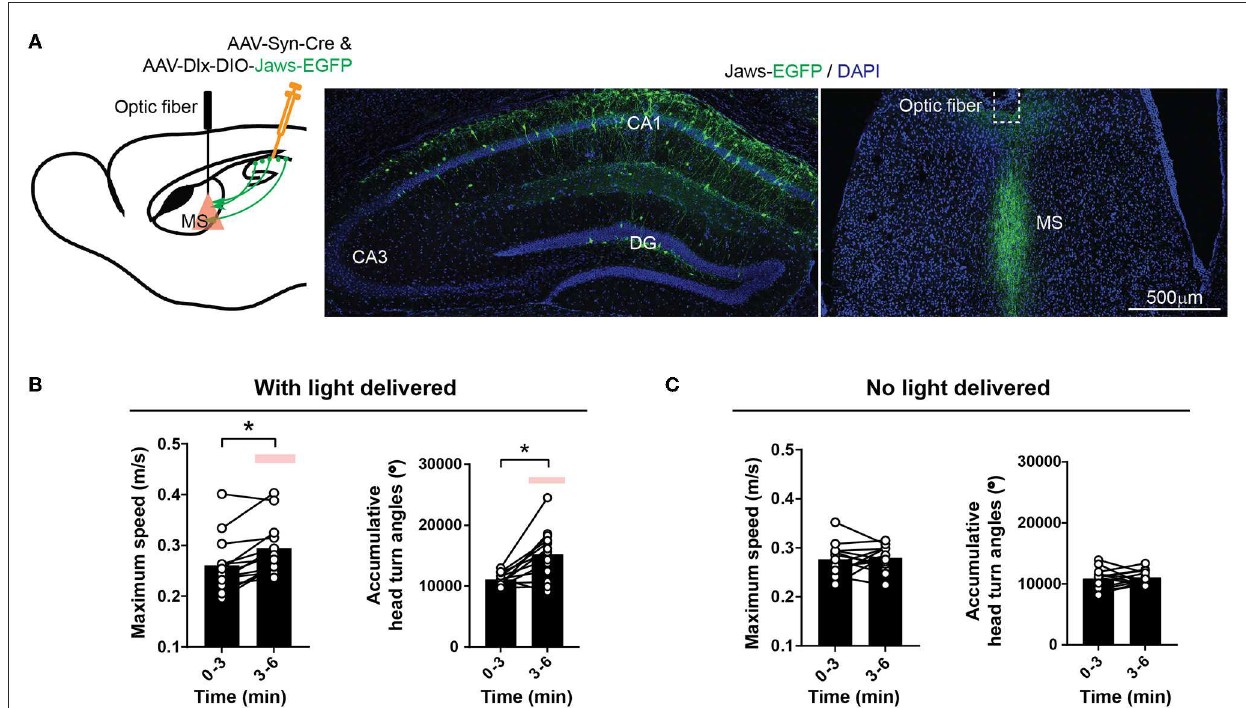
FIGURE5 Inhibiting inhibitory hippocampal output to the MS increases locomotion. (A) Optogenetic inhibition of the hippocampal inhibitory inputs to the MS by light delivered into the MS. An inhibitory opsin, Jaws, was expressed in the hippocampal GABAergic neurons with AAVs. (B) Red light delivered to the MS increased mouse locomotion measured by maximum speed and accumulative head turn angles in the open field. (Two-tailed paired t -test, * p < 0.05) (Dlx-Jaws, n = 13 mice). The red bars indicate the delivery of optostimulation. (C) No change in maximum speed (left) or accumulative head turn angles (right) occurred when the optical stimulation was not delivered (Left: Two-tailed paired t -test, p = 0.77; Right: Two-tailed paired t -test, p = 0.71) (Dlx-Jaws, n = 13